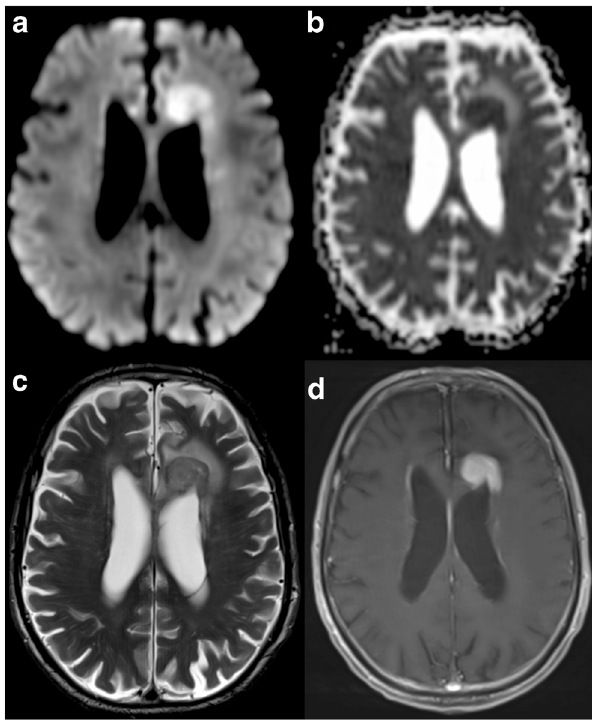
Fig. 5 Primary CNS lymphoma. Left frontal periventricular lesion showing prominent diffusion restriction, presenting with hyperintensity on DWI ( a ), low ADC value ( b ) and mild hyperintensity on T2WI ( c ), all typical features of this type of hypercellular tumour. T1WI post gadolinium ( d ) shows homogeneous and intense contrast enhancement